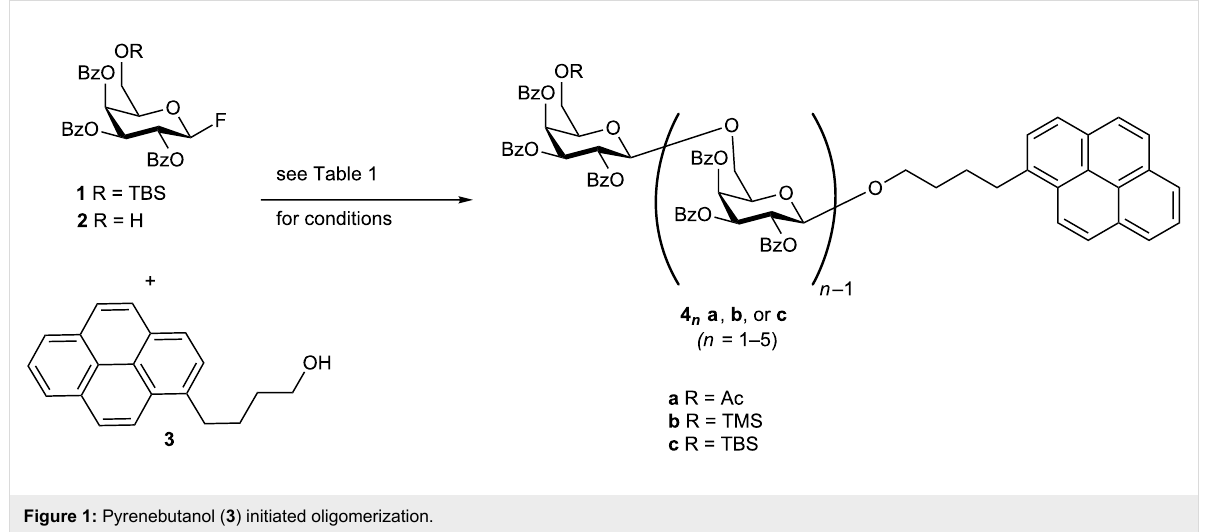
Figure 1: Pyrenebutanol ( 3 ) initiated